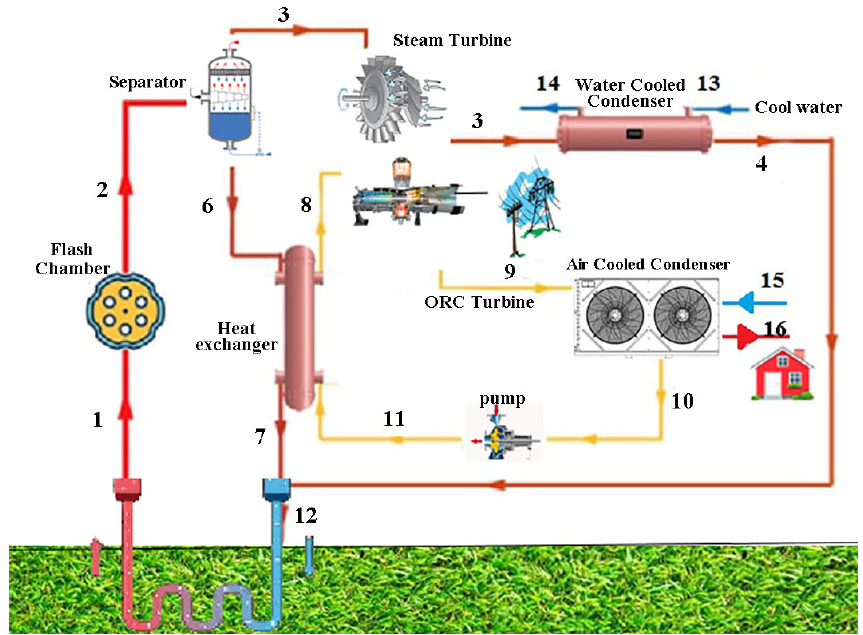
Figure 1. Geothermal system to produce heat and power. The ORC, which uses zeotropic fluid, uses geothermal fluid heat in the heat ex- changer to evaporate its working fluid. The zeotropic fluid, which consists of a combina- tion of three hydrocarbons (hexane, cyclohexane, and isohexane) and two refrigerants (R236ea and R245fa), enters the turbine after evaporation (point 8). The turbine generates electricity by expanding and reducing the flow pressure by connecting to the generator. output flow from the turbine (point 9) is condensed in the condenser (point 10) and finally sent back to the heat exchanger by the pump (point 11). Figure 2 shows a T-s diagram of the ORC with zeotropic working fluid.